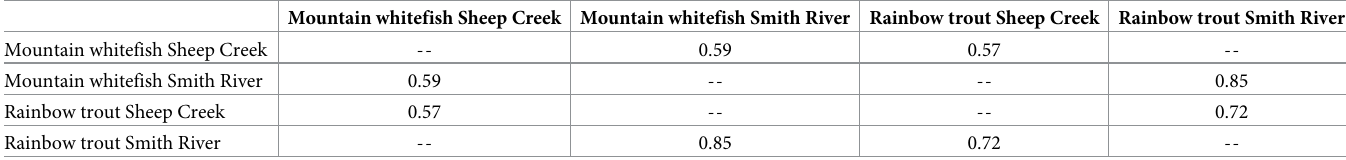
Table 3. Niche overlap. Pianka’s index of niche overlap comparing diets of mountain whitefish and rainbow trout in Sheep Creek and the Smith River. Values � 0.60 indicate high diet